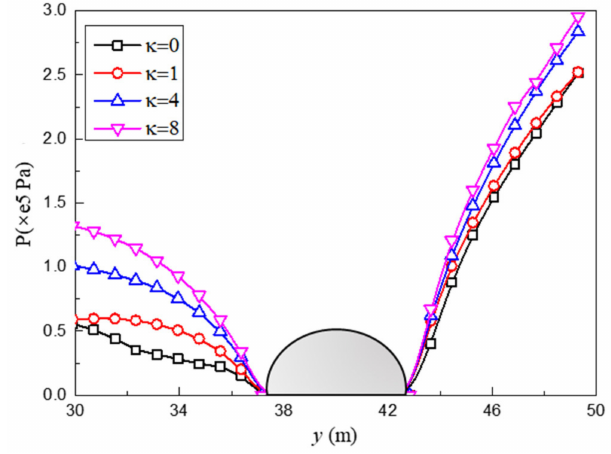
Figure 8. Water pressure distribution of tunnel rock at [30, 50] range under different κ values.